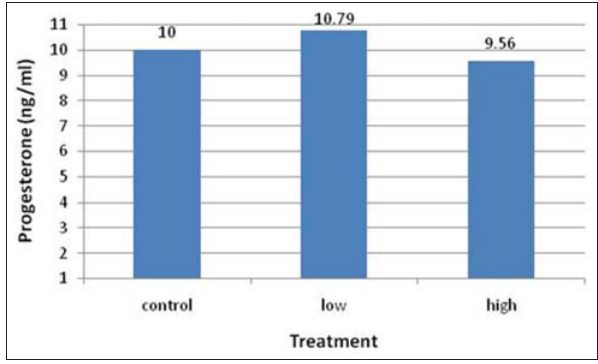
Figure-3: Blood progesterone level in control, low and high-recombinant human follicle stimulating hormone- treated cows.